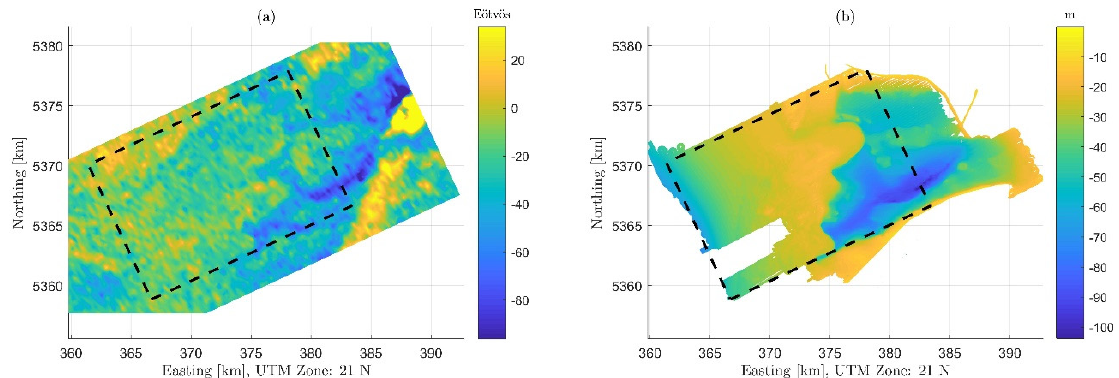
Figure 3. ( a ) The vertical-vertical gravity gradient measurements; ( b ) The 10 m × 10 m multibeam bathymetry used to evaluate the inversion results. The black dashed lines mark the range of the study region.